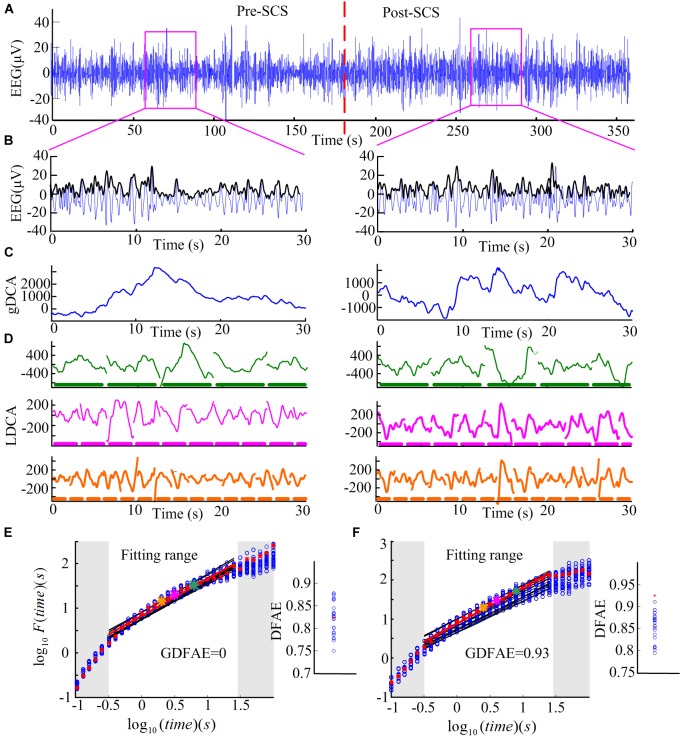
Step-by-step illustration of DFAE calculation. (A) Delta band preprocessed EEG signals totaling 6 min (3 min before SCS and 3 min after SCS) from participant No. 2 at channel FP2. The red dash line denotes the SCS. (B) Delta band EEG signals of 30 s were extracted from the two states (blue line) and amplitude envelope (black line). (C) Detrended cumulative amplitude, without the global linear trend, of both states. (D) LDCA of time window of length 6.3 s (top), 3.2 s (middle), and 2.0 s (bottom); the thick dash line parallel to the timeline represents the time windows, the length of each piece on behalf of the length of the time window–green for 6.3 s, pink for 3.2 s, and orange for 2.0 s. (E) The fitting of the logarithmic fluctuation function for both real EEG signals and surrogate EEG data performed for the pre-SCS state; red asterisks and hollow blue circles represent the real and the surrogate EEG respectively. The big asterisks correspond to the same color time window in panel (D). The red and black lines are the linear regression fitted lines. To obtain a reliable exponent, the log times (windows) in the gray area were excluded from the linear regression. The windows which are too narrow (in the lower left corner) exhibit inherently steeper scaling, whereas windows too large (i.e., those in the upper right corner) may induce the lacking of data for reliably estimating the variability. The right part is the corresponding slope (DFAE) value of the function. The blue circles represent DFAEsurr and the red asterisk represents DFAEoriginal. This significance test shows that this channel, in this state, is a spurious DFA channel. Thus, the GDFAE = 0. (F) The fitting of the logarithmic fluctuation function for the post-SCS state. Similar to panel (E), but the significance test showed that it is a genuine DFA channel in this state (GDFAE = DFAEoriginal = 0.9251).